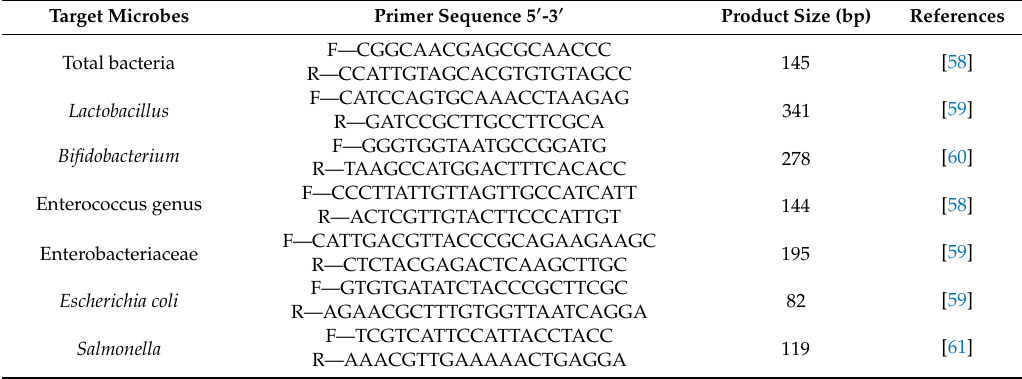
Table2. Theprimersequencesofcaecaltargetingtotalbacteria, Lactobacillus , Bifidobacterium, Enterococcus , Enterobacteriaceae, E. coli , Salmonella